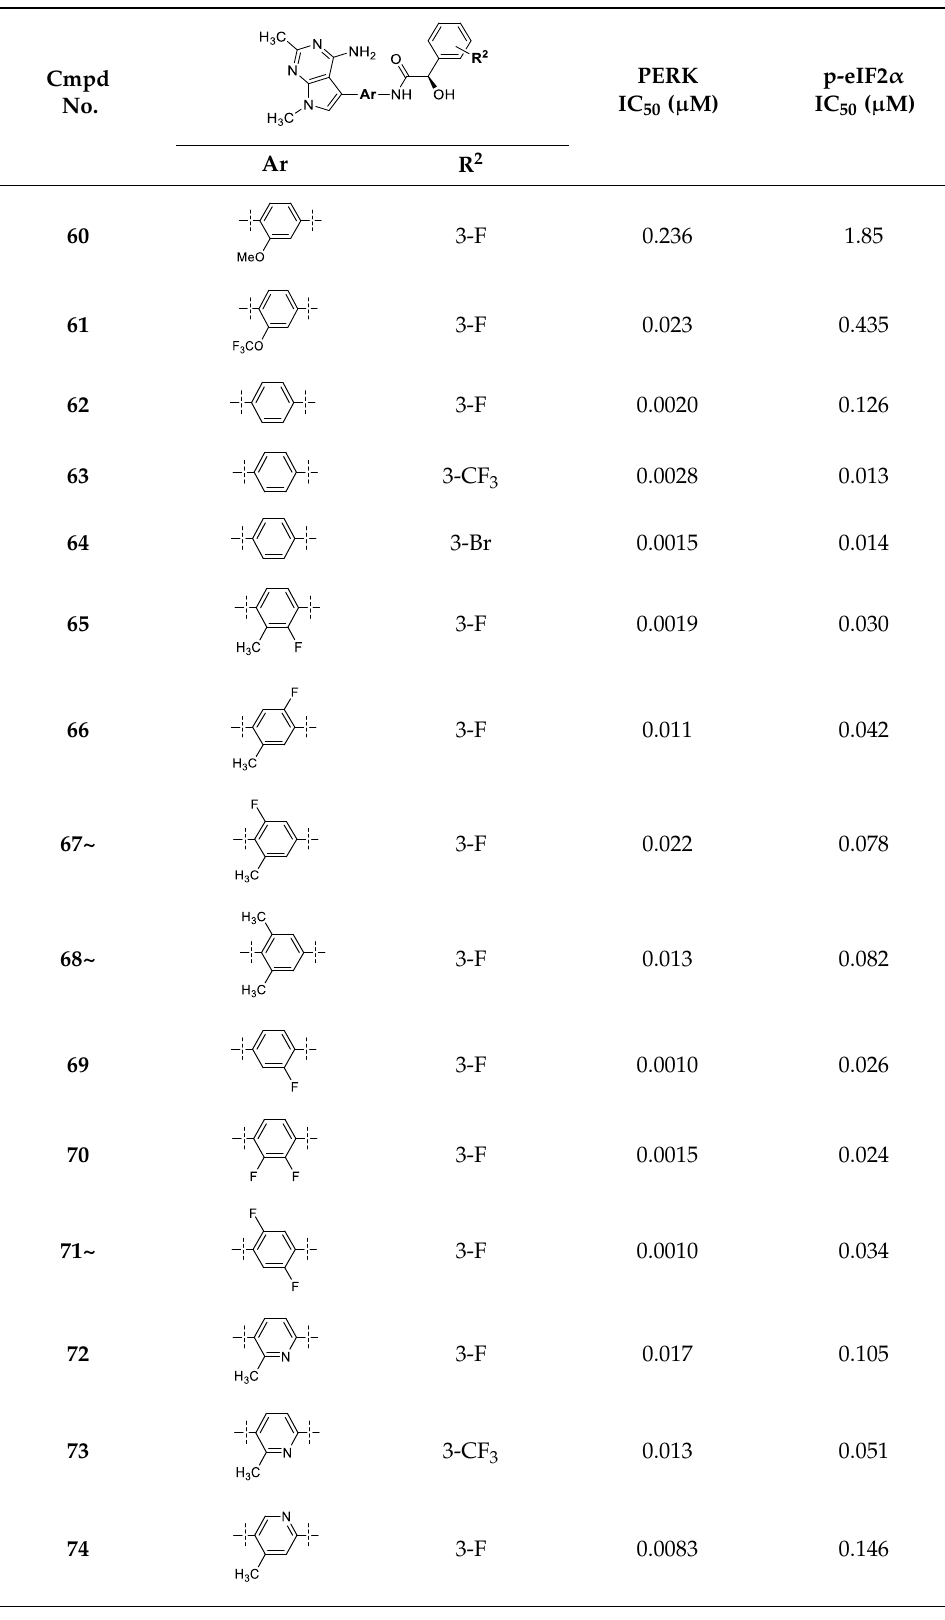
Table 3. In vitro data of PERK inhibitors with proximal and terminal ring Table 3. Cont .